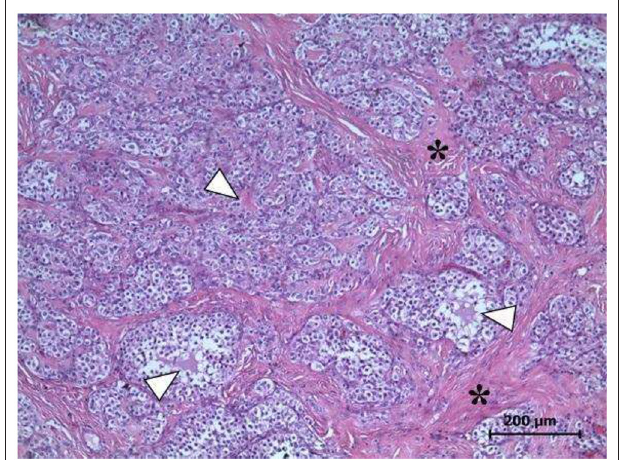
FIGURE 3 | Left ovary. Microscopic evidence of GCT. The Call-Exner bodies, pathognomonic of GCT (arrowheads), and abundant stromal tissue (asterisks) are observed. Several areas exhibit the typical Sertoli pattern H&E Staining, 400X. Scale bar: 200 µ m.